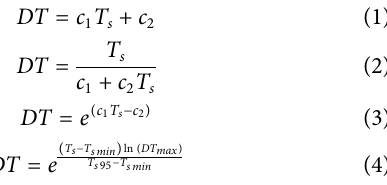
Frontiers in Earth Science |